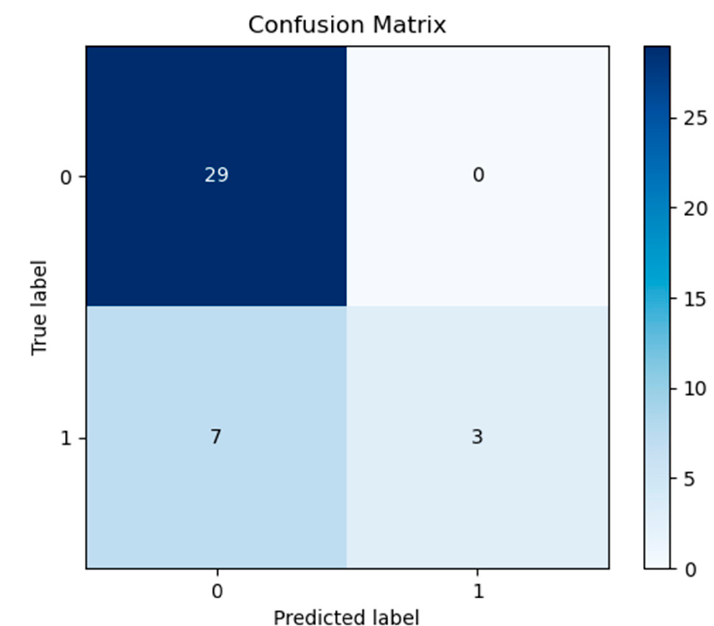
Figure 4. Confusion Matrix. On the main diagonal the predictions made by the machine are reported. Thus, the model was able to correctly answer 29 times in order to identify the true negative group and three times in order to identify the true positive, while it made an error seven times for the false negative. No false positive was detected.